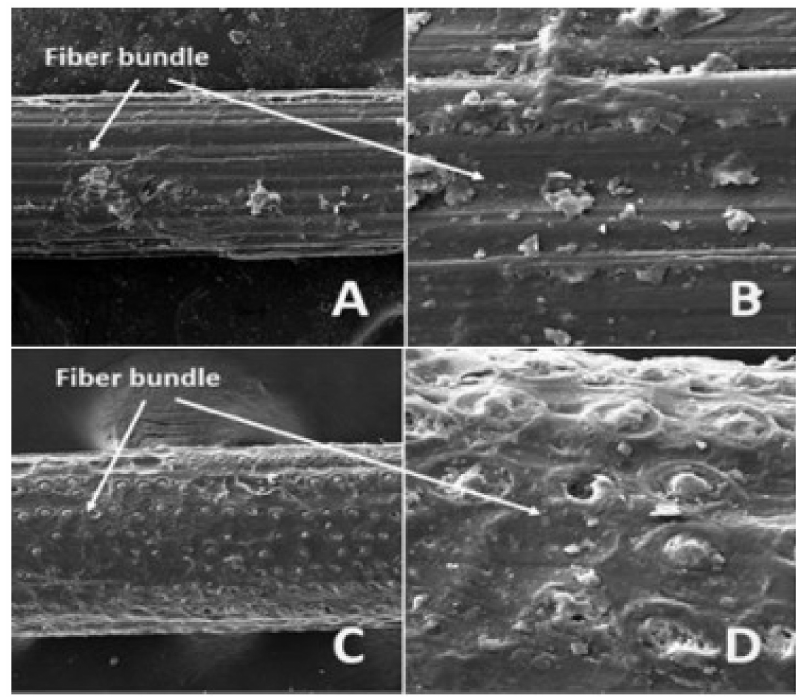
Figure 14. SEM images of untreated abaca and coir fibers: ( A ) abaca fiber bundle (@ mag 750 x), ( B ) abaca fiber detailed surface view (@ mag 3.5 kx), ( C ) coir fiber bundle (@ mag 750 x), and ( D ) coir fiber detailed surface view (@ mag 3.5 kx)